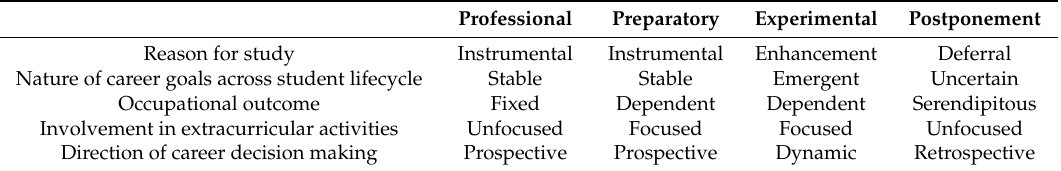
Table 5. Dimensions of career planning by types of career